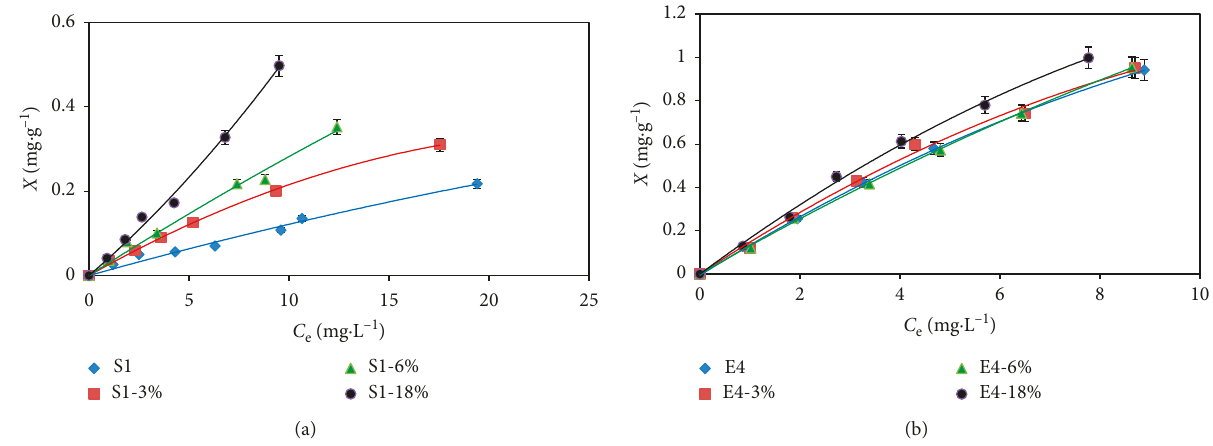
Figure 2: Flusilazole adsorption isotherms on original and amended S1 (a) and E4 (b) soil samples.